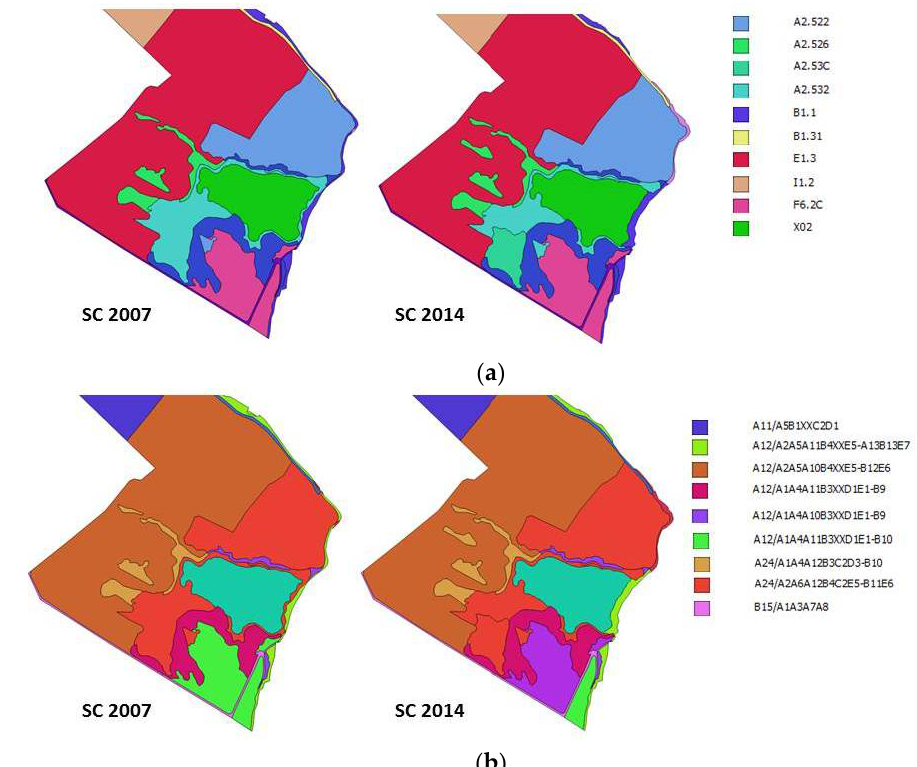
Figure 20. In LCCS ( b ), helophytes are treated as a unique class (A24/A2A6A12B4C2E5-B11E6 (Perennial closed tall grasslands on temporarily flooded land)). In such cases, EUNIS ( a ), with its detailed list of vegetation types, becomes fundamental for discrimination among these classes.